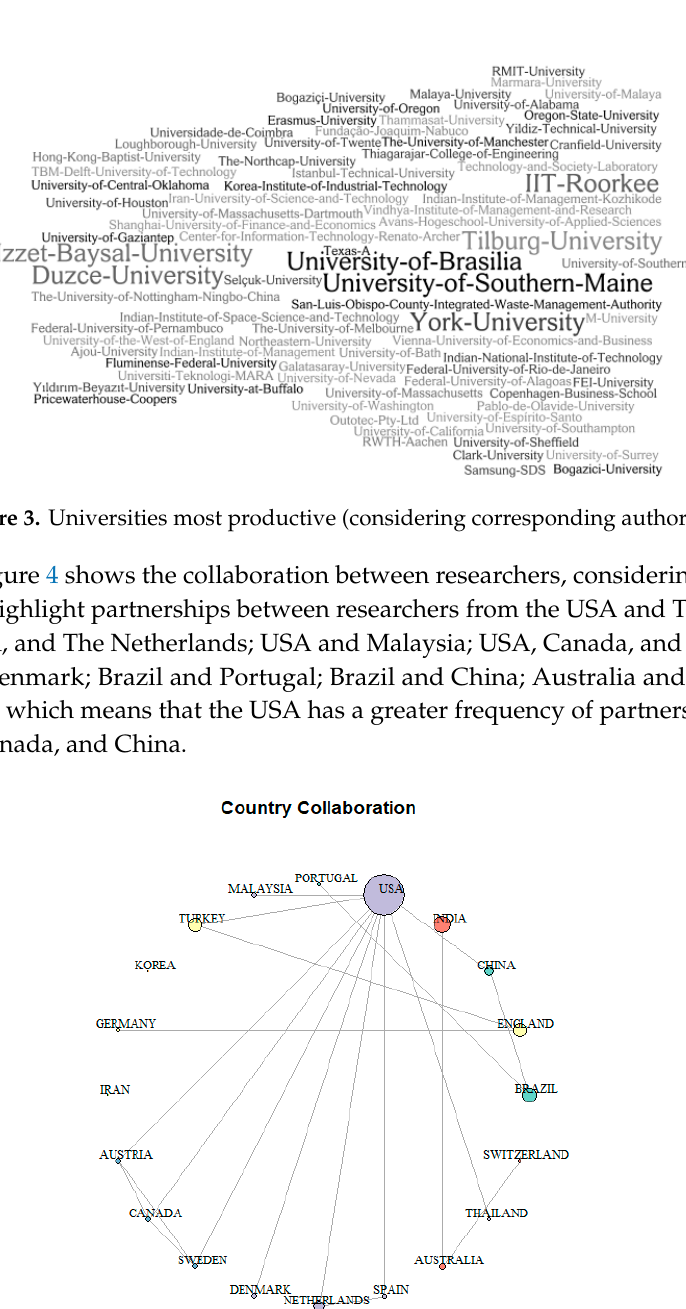
Figure 4. Collaboration between researchers from different countries.